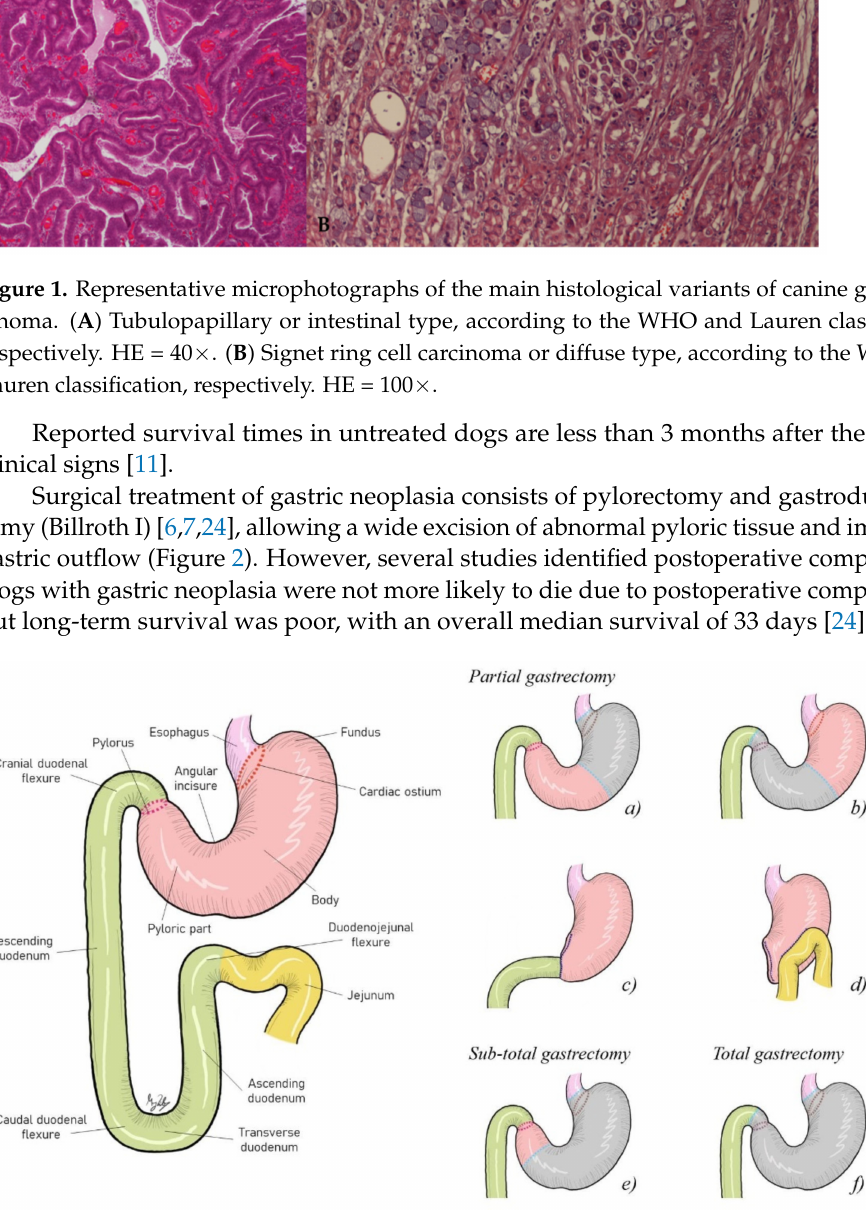
Figure 2. ( a , b ) Partial gastrectomy ( ≤ 70% of the stomach removed). ( c ) Billroth I (gastroduodenos- tomy), a reconstruction technique after partial gastrectomy. ( d ) Billroth II (gastrojejunostomy), a reconstruction technique after partial gastrectomy. ( e ) Subtotal gastrectomy (>70% but not complete stomach removal). ( f ): Total gastrectomy (complete stomach